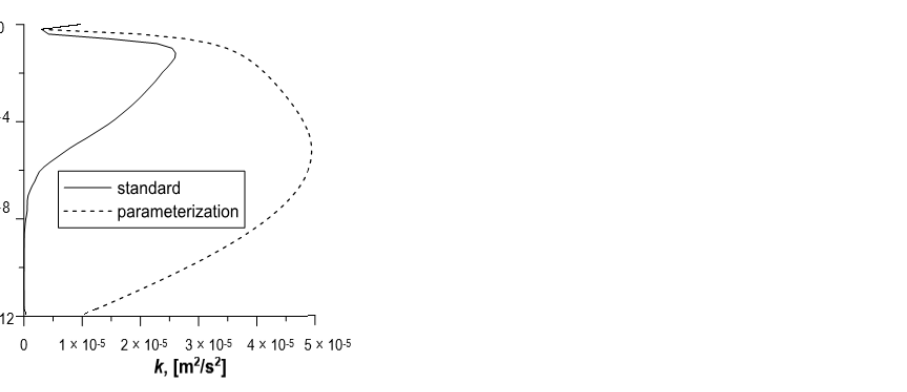
Figure 4. Profiles of the kinetic energy of turbulence using the standard and modified schemes in the lake.